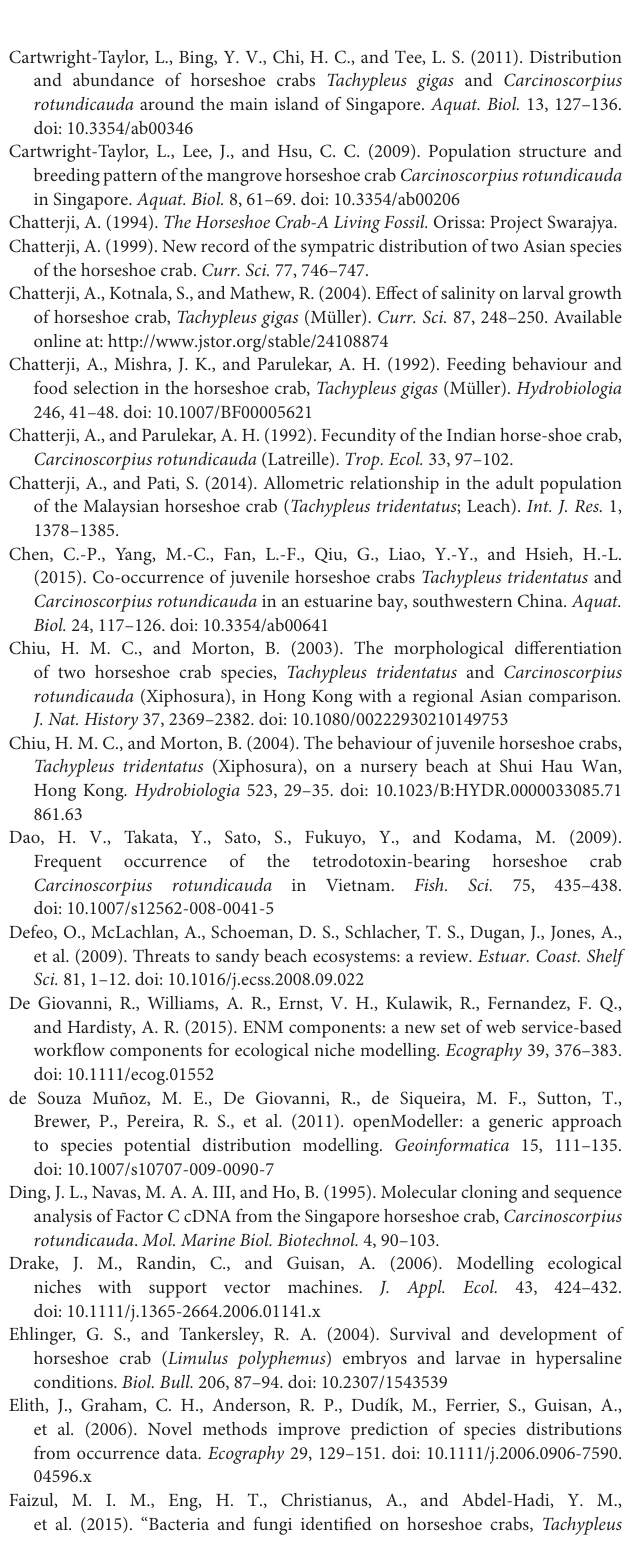
Supplementary Table 7 | Loadings for the different environmental variables shown for all PCA components for T. gigas . Supplementary Table 8 | Loadings for the different environmental variables shown for all PCA components for T. tridentatus